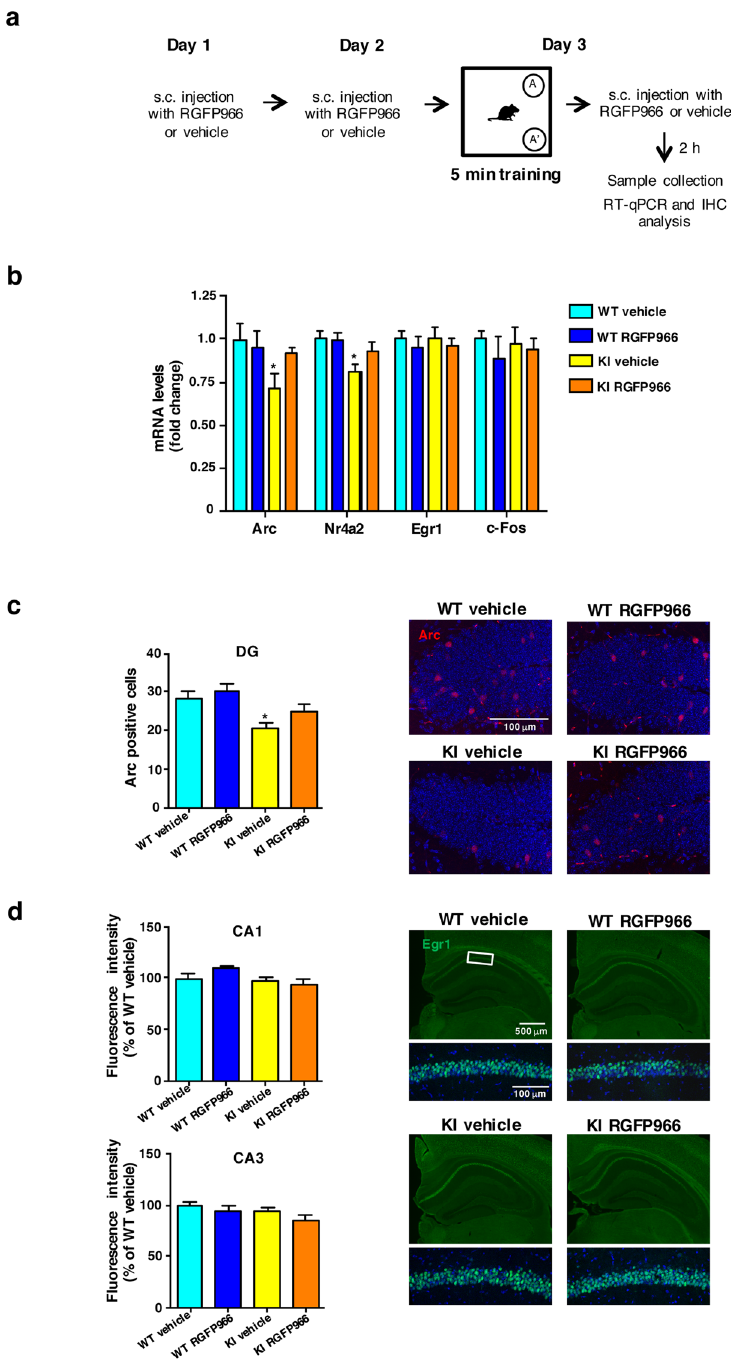
Figure 3. RGFP966 treatment restores gene expression in the hippocampus of HD mice. (a) Schematic time line of acute treatment. ( b) Quantitative RT-PCR analysis of memory-related genes in the hippocampus of vehicle and RGFP966 acutely treated Hdh Q7/Q7 (WT) and Hdh Q7/Q111 (KI) mice. Histogram represents relative mRNA abundance of Arc, Nr4a2, Egr1 and c-Fos . Levels of mRNA were normalized to 18S and Actin β . * p < 0.05 compared to vehicle-treated WT mice by two-way ANOVA with Bonferroni post-hoc analysis. (c) Representative images (high magnification) showing Arc immunostaining in the hippocampal dentate gyrus of acutely treated Hdh Q7/Q7 (WT) and Hdh Q7/Q111 (KI) mice. Histogram shows quantification of the average number of Arc-positive neurons in the dentate gyrus. * p < 0.05 compared to vehicle-treated WT mice by two- way ANOVA with Bonferroni post-hoc analysis. (d) Representative images with magnification insets of the hippocampal CA1 region showing Egr1 immunostaining in acutely treated Hdh Q7/Q7 (WT) and Hdh Q7/Q111 (KI) mice. Histogram shows quantification of the average intensity of Egr1 immunoreactivity in the CA1 or the CA3 region. Data represent the mean ± SEM (n = 5–8 animals per